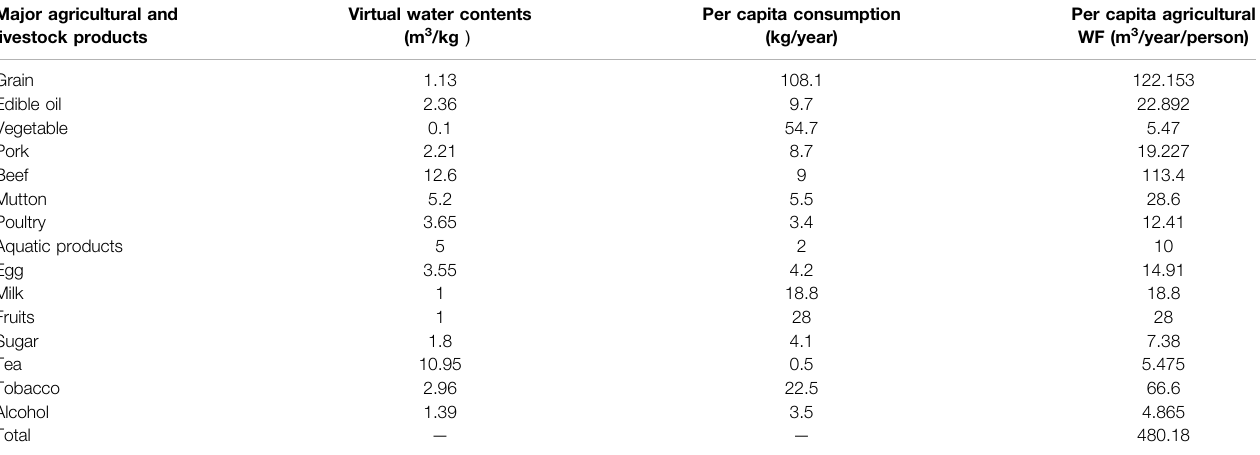
TABLE 3 | Virtual water contents, per capita consumption of agricultural and livestock products and per capita agricultural WF. Major agricultural and livestock products